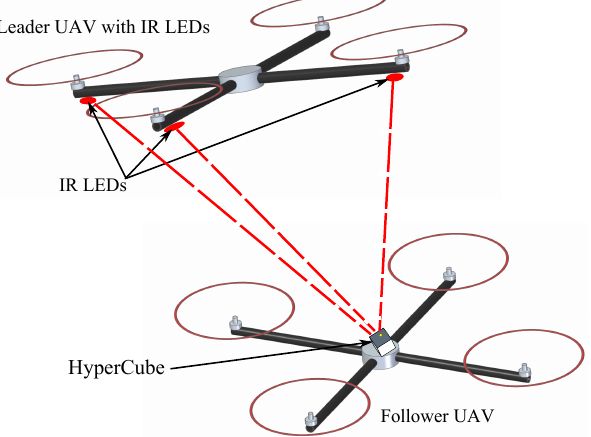
Figure 1. Sketch of a collaborative flight using IR LEDs and the HyperCube sensor embedded onboard the